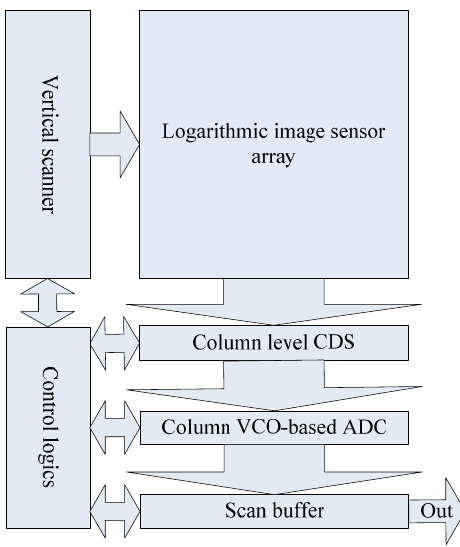
Figure 2. The proposed sensor architecture including a logarithmic image sensor with on-chip CDS and a VCO based